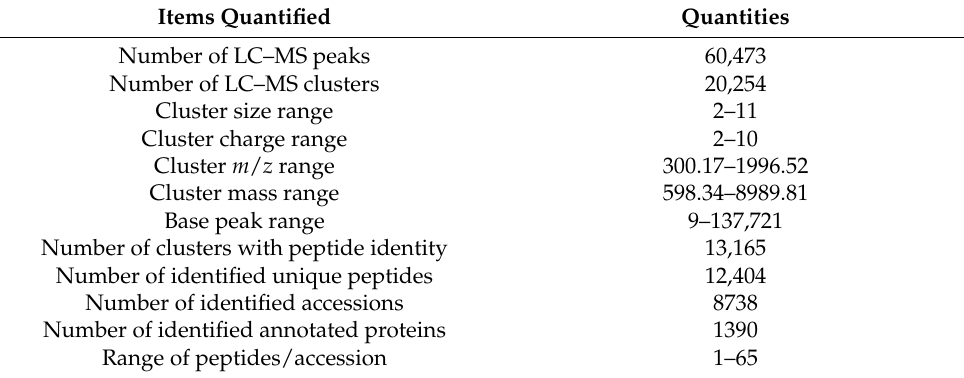
Table 1. Summary of wheat grain